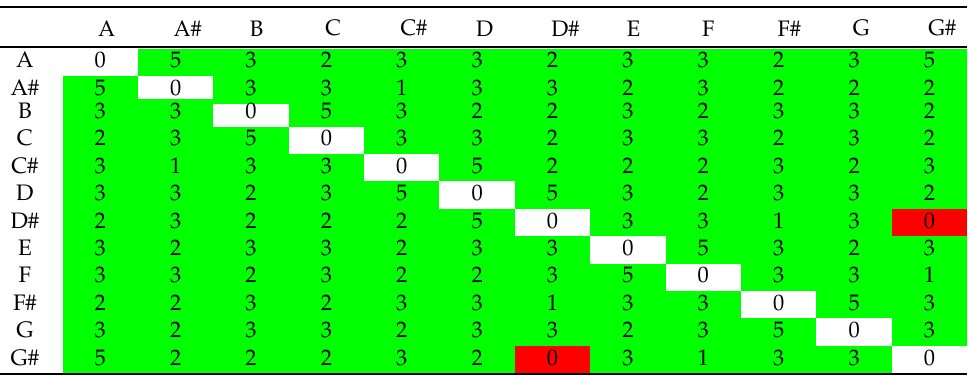
Table 3. Chest organ compliance matrix for Pietro Aaron’s temperament ( p k = 0.985; σ cent = 0.53 cent).